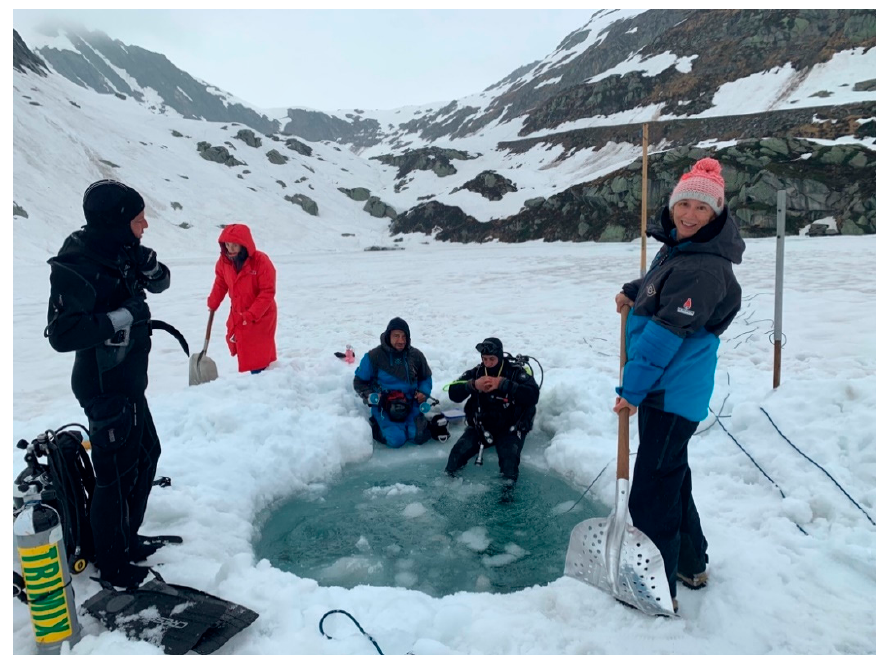
Figure 2. View of sampling conditions at the main hole at alpine Lake Sassolo (June 2019) Photo made by: Odysseus 3.1.